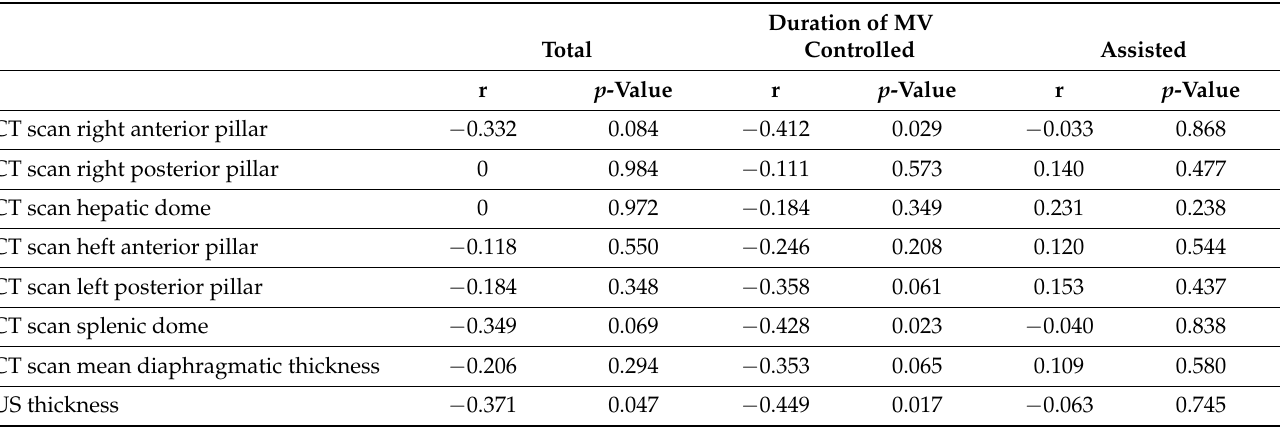
Table 2. Correlation between diaphragmatic thickness and duration of mechanical ventilation until enrollment.